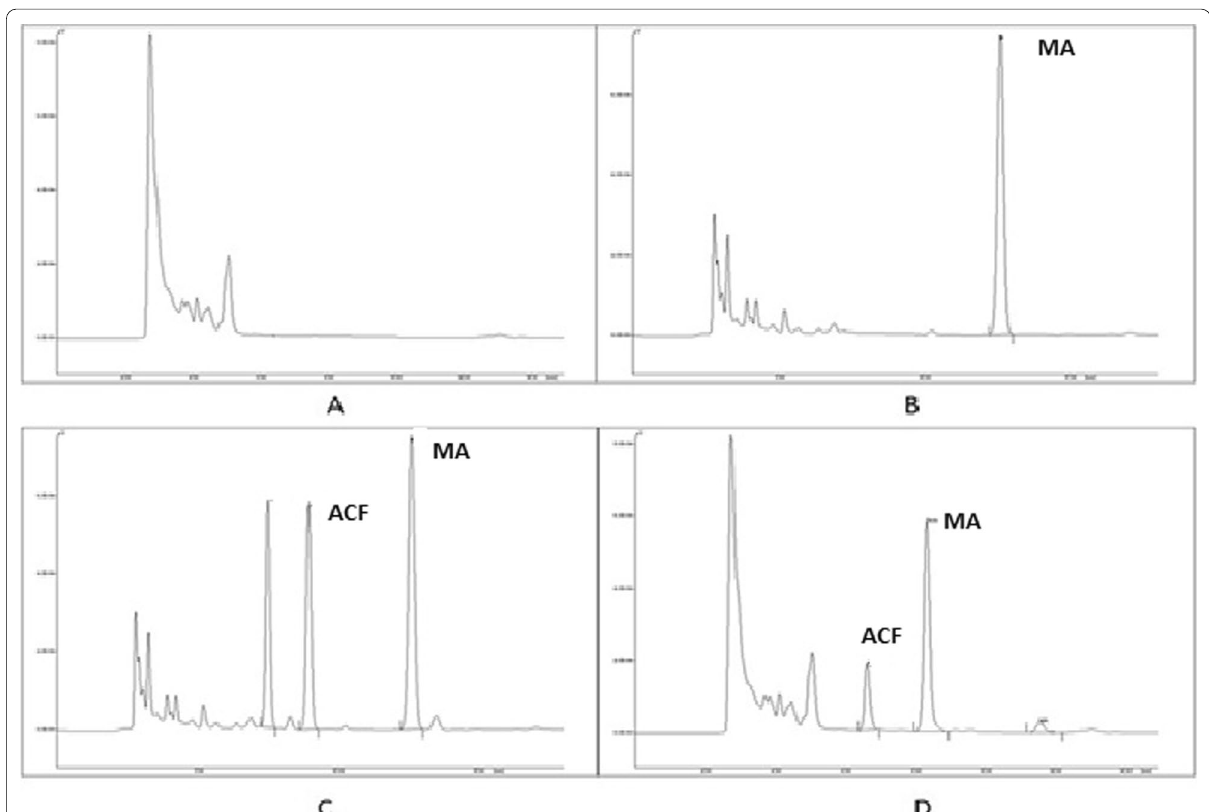
Fig. 2 Chromatogram of A blank plasma sample B blank plasma sample with MA (IS) C plasma sample spiked with I. S. MA (10 µg/ml) and ACF (10 µg/ml) D a plasma sample obtained from rat at 1.5 h after oral administration of ACF